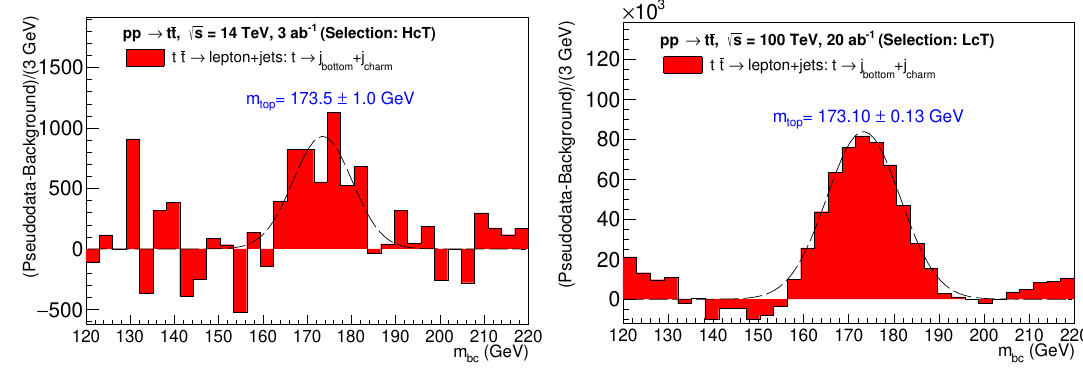
Figure 3 . Expected background-subtracted invariant mass distributions for pairs of charm and bottom jets reconstructed in the t ! b c analysis in simulated pp collisions at and 100 TeV (right) after cuts for the ‘HcT’ and ‘LcT’ charm jet reconstruction performances, respectively, discussed in the text. The dashed line shows a Gaussian (cid:12)t to the distributions, with the (cid:12)tted value of the top-quark mass listed above